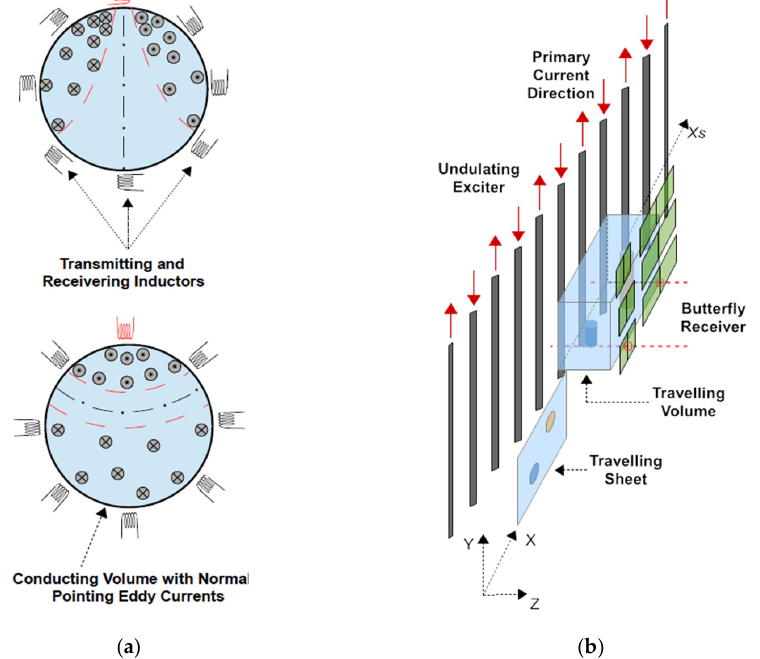
Figure 1. Structures of different MIT systems: ( a ) Top view of a typical annular MIT setup with small and localized transducers in two different orientations. The highest current densities appear near the exciting inductor (red) and a central region with vanishing eddy currents occurs [20]; ( b ) Illustration of a planar MIT scanner with a large and undulating exciter (undulator).